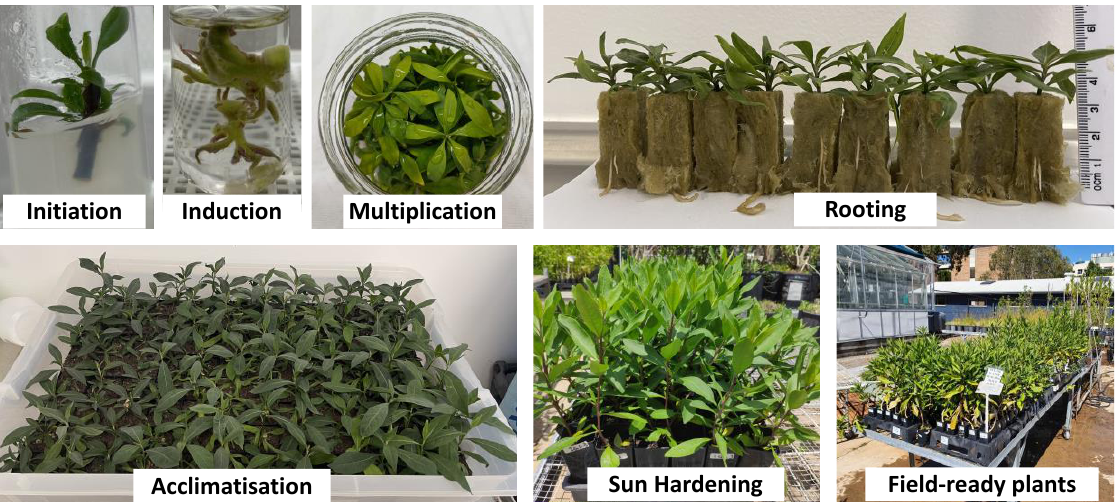
Figure 1. Meristem culture micropropagation platform for M × L hybrid. Adapted from Mason et al. [128].